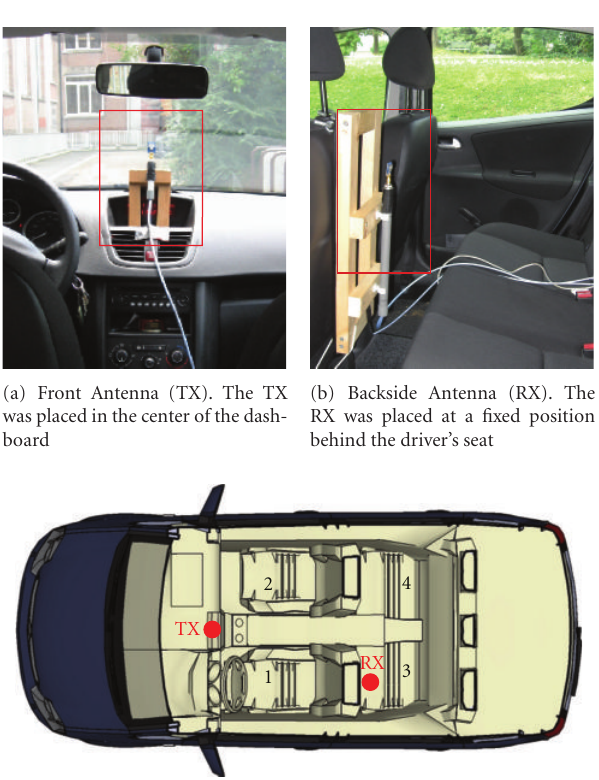
Figure 1: Pictures and top view of the experimental